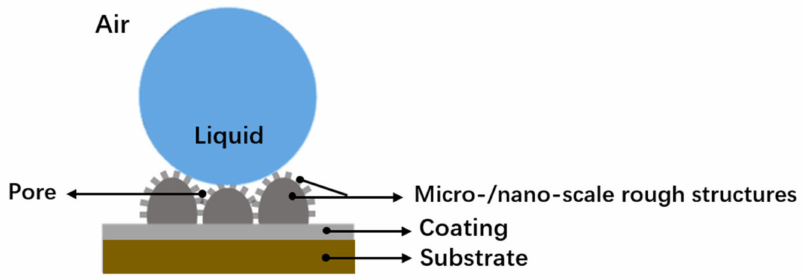
Figure 13. Schematic diagram of the mechanism of micro-/nano-scale rough structures in enhancing the hydrophobic properties of composite coating